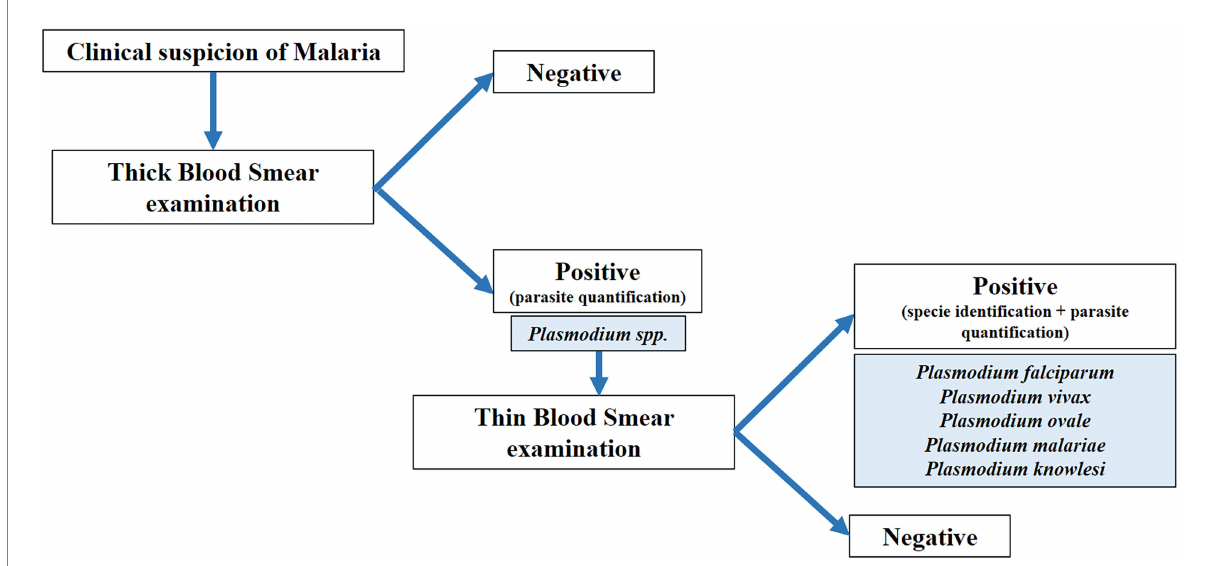
FIGURE 2 Blood smear microscopic examination procedure. Thick blood smear is first examined to determine the presence of malaria parasites. If the sample is positive, a thin blood smear is examined to determine Plasmodium species identification. Parasite quantification is performed to determine severity of the